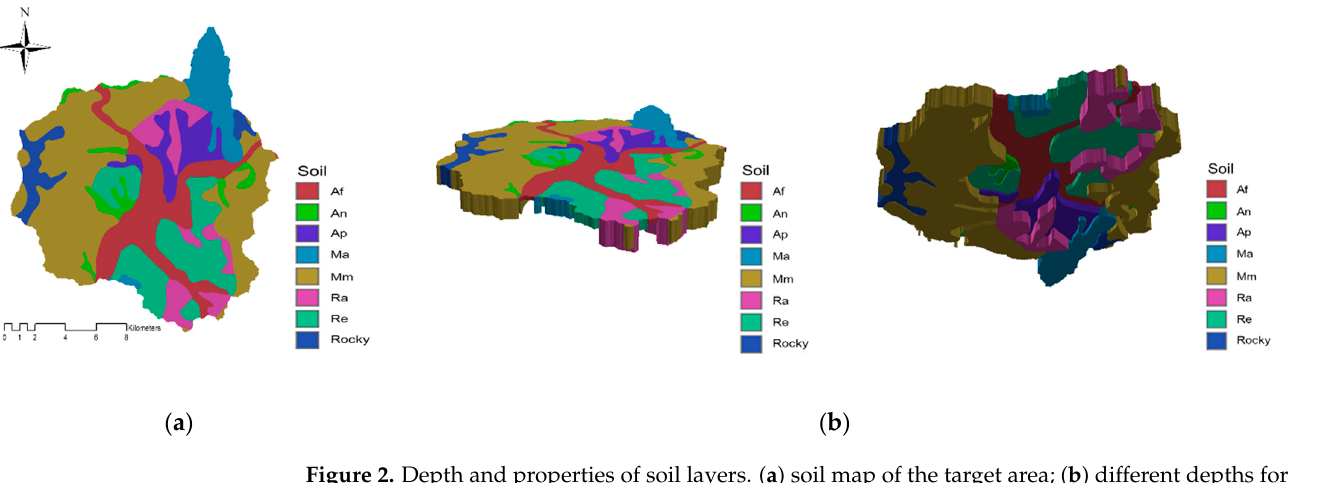
Figure 2. Depth and properties of soil layers. ( a ) soil map of the target area; ( b ) different depths for each 3D soil type.